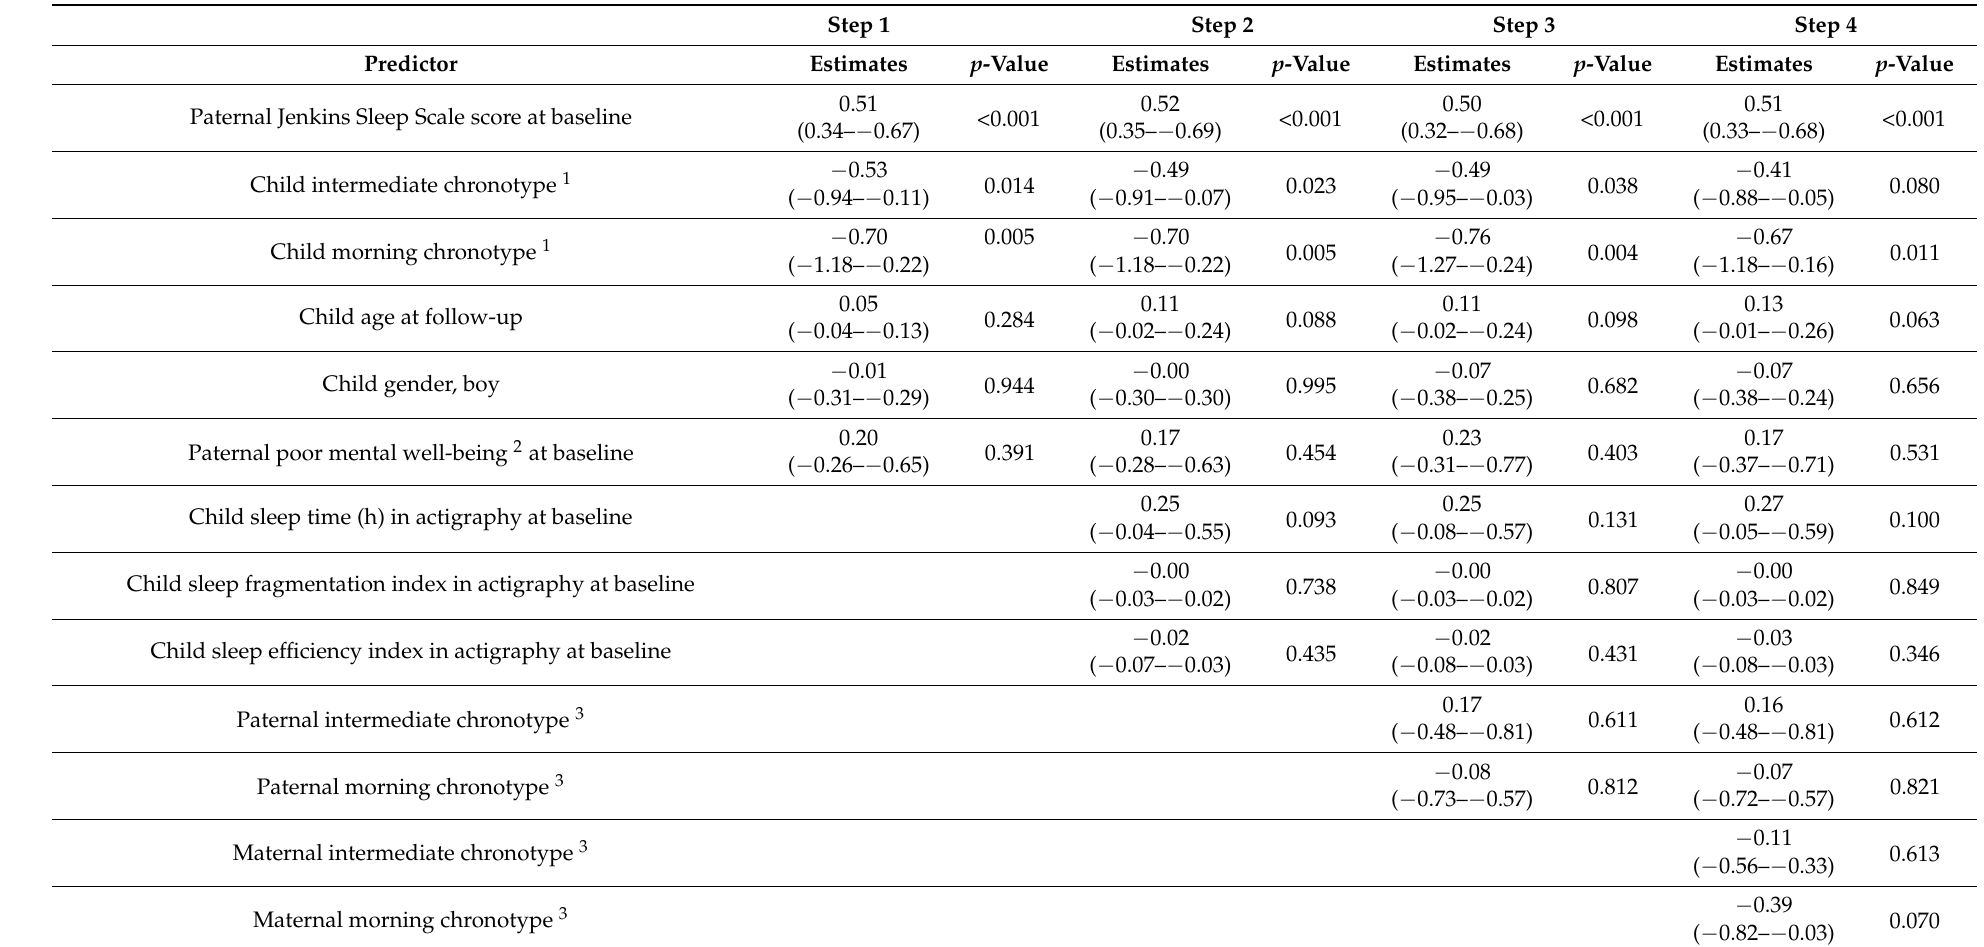
Table 4. Effect of different variables on paternal sleep assessed with the Jenkins Sleep Scale at 1-year